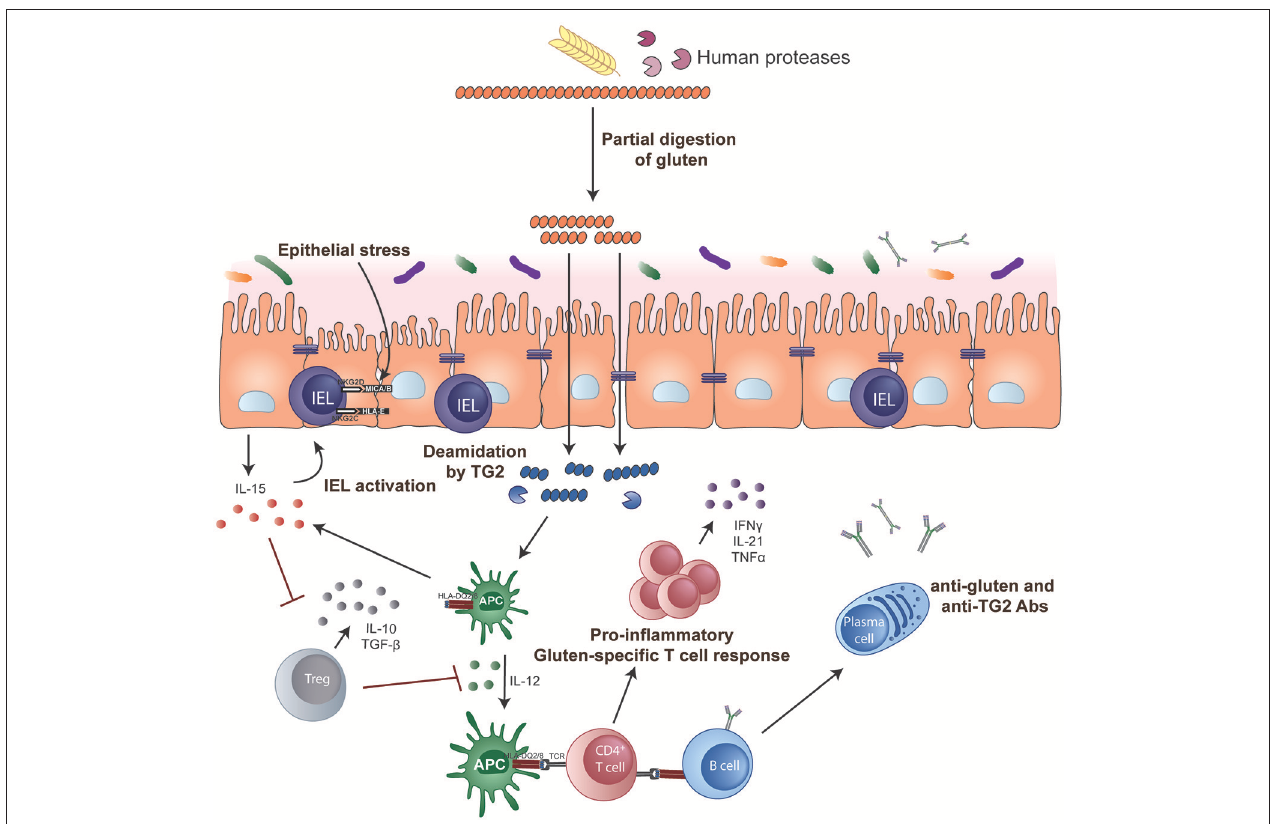
FIGURE 1 | Key steps in CeD pathogenesis. Gluten peptides containing T-cell epitopes resist gastrointestinal degradation. tTG catalyses the deamidation of gluten peptides, which can then bind more efficiently to the disease-relevant HLA-DQ molecules on APCs. Activated gluten-specific CD4 + T cells secrete a variety of pro-inflammatory cytokines such as IFN- γ and IL-21 that contribute to the intestinal lesion and promote activation of IELs and stimulate B-cell responses. Activated IELs transform into cytolytic NK-like cells that mediate destruction of enterocytes expressing stress signals. IL-15 renders effector T cells resistant to the suppressive effects of Tregs and, in the lamina propria, endows mucosal DCs with inflammatory properties promoting pro-inflammatory responses and preventing Treg